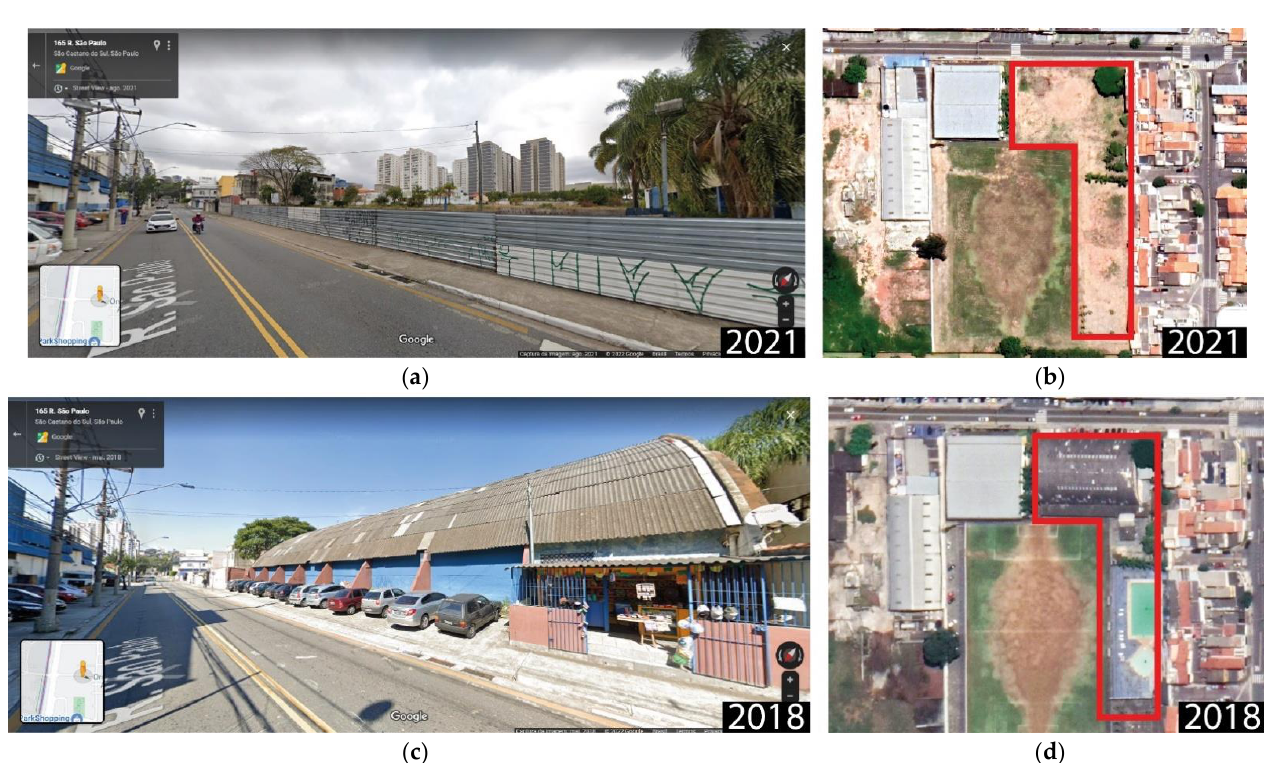
Figure 3. Example of a land use change update for generating the 2021 land use map: ( a ) street view of a multi-sports facility in 2018, ( b ) satellite view of this facility in 2018, ( c ) street view of this plot after demolition in 2021, ( d ) satellite view of this vacant plot in 2021. Sources: [42,43].